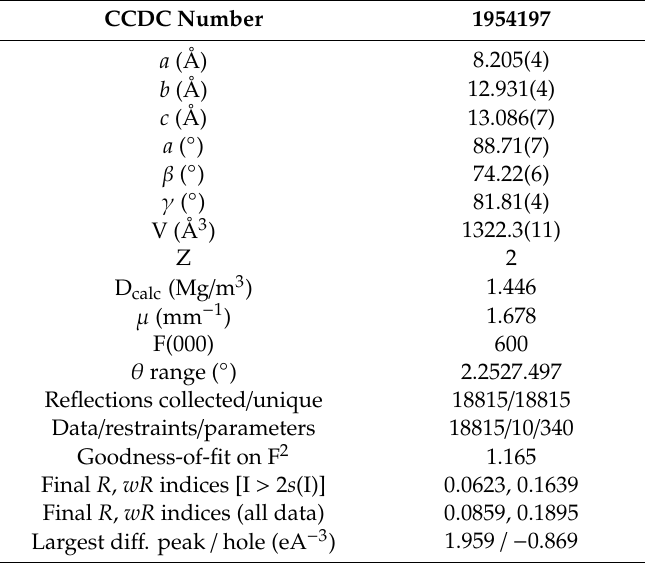
Table 2. Crystal data and structure refinement details for BTABr.